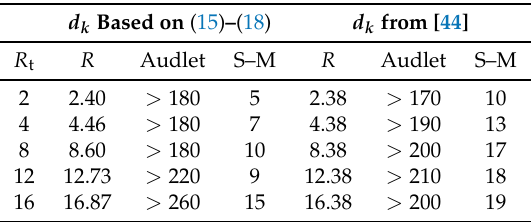
Table 2. Signal-to-noise ratios (SNRs; in dB) obtained for the Audlet framework and reported in [44] (Figure 10)